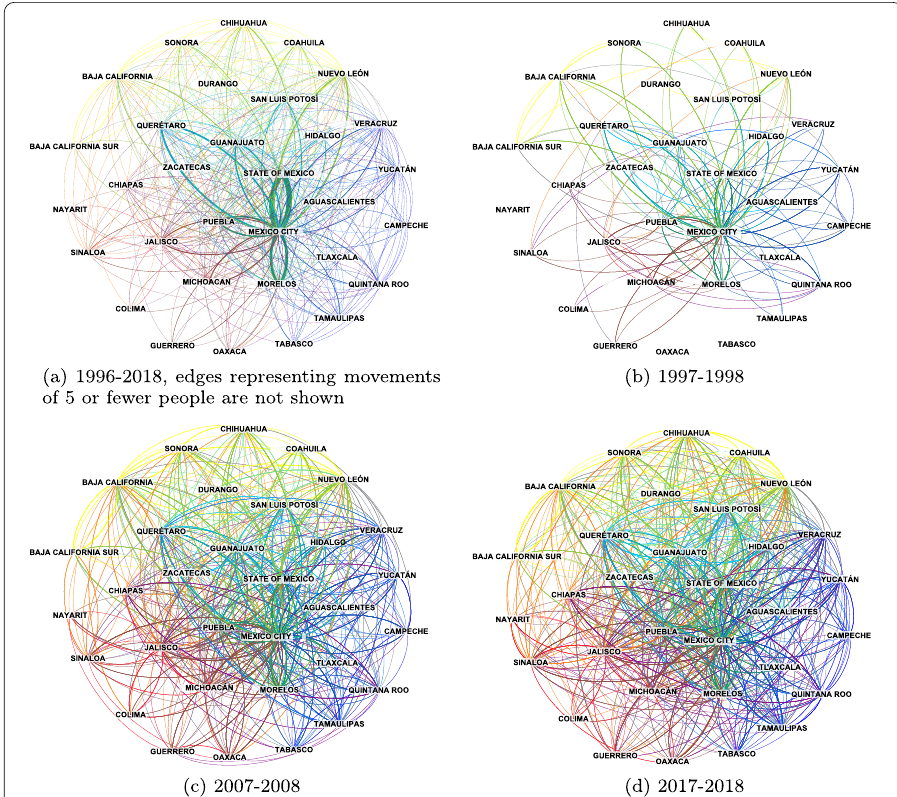
Figure 9 Network of internal migration among researchers in Mexico in 1996–2018 in which intensity of movements is shown by the thickness of the edges (a), three cross-sectional networks based on selected one-year periods (b-d). Directions of edges are clock-wise and their colors are the mix of respective origins and destinations (see the figure on screen for high resolution)